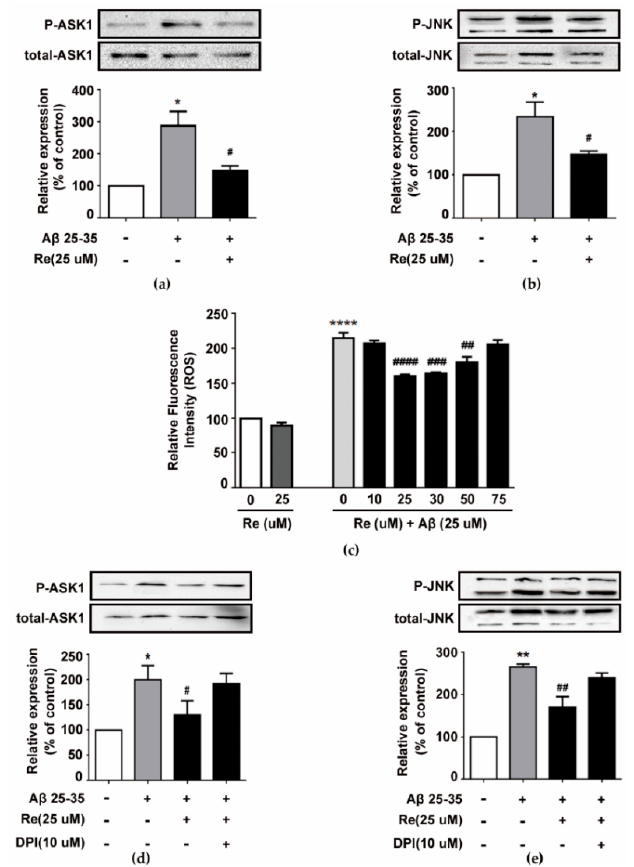
Figure 3. Inhibition of A β -induced ASK1 / JNK pathway by ginsenoside Re is dependent on attenuation of A β -induced excessive reactive oxygen species (ROS) generation. ( a ) Level of p-ASK1 was analyzed by western blot and the band intensity of p-ASK1 was quantified by densitometry and normalized to total ASK1; ( b ) level of p-JNK was analyzed by western blot and the band intensity of p-JNK was quantified by densitometry and normalized to total JNK; ( c ) intracellular ROS were estimated using the fluorescent probe DCFH-DA by Amnis flow cytometry; ( d , e ) SH-SY5Y cells were pre-treated with or without DPI (NADPH oxidase inhibitor diphenyleneiodonium) for 50 min and then treated with Re in the presence or absence of A β for 24 h. Level of p-JNK and p-ASK1 was analyzed by western blot. * p < 0.05, ** p < 0.01, **** p < 0.0001 versus control; # p < 0.05, ## p < 0.01, ### p < 0.001, #### p < 0.0001 versus A β treatment